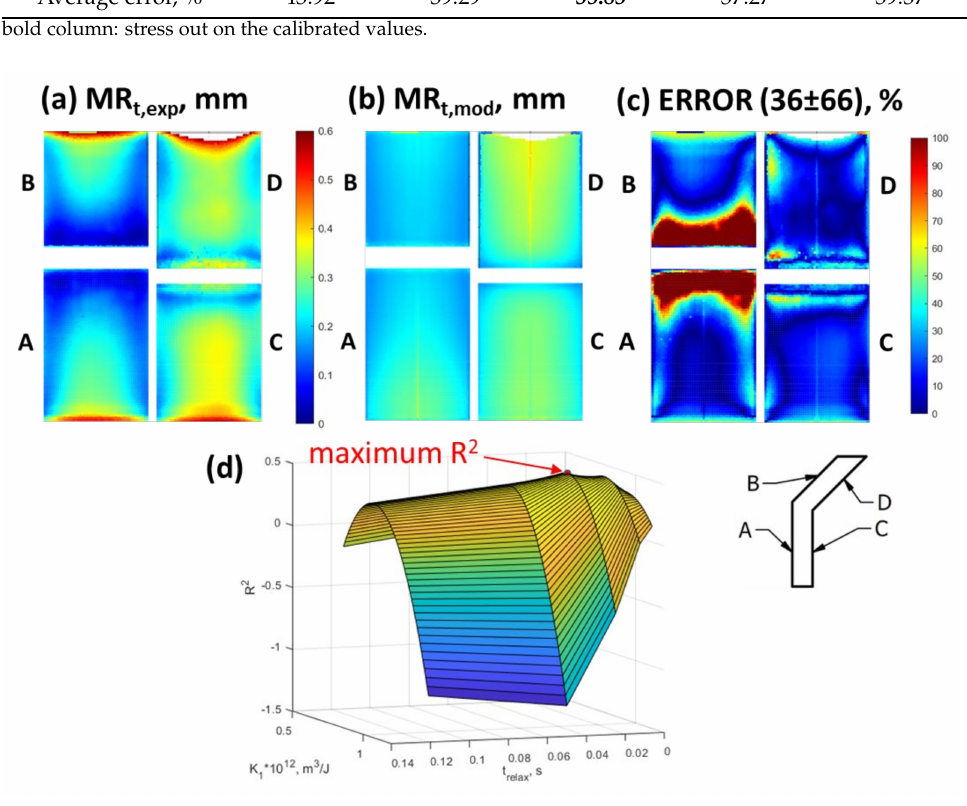
Figure 15. Pre-polished V-shape artifact after 950 AFM passes: ( a ) experimental MR t ( MR t,exp ); ( b ) calculated MR t ( MR t,mod ); ( c ) error: MR t,exp vs. MR t,mod ); ( d ) definition of the optimal τ and K 1 (maximum R 2